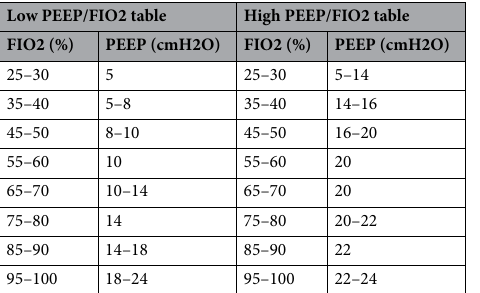
Table 1. PEEP/FIO2 tables. FIO2 Inspired oxygen fraction, PEEP Positive end-expiratory